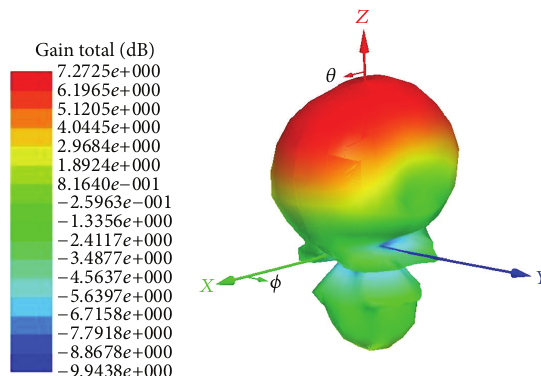
Figure 3: Simulated 3D radiation pattern of the Vivaldi element at 6GHz.